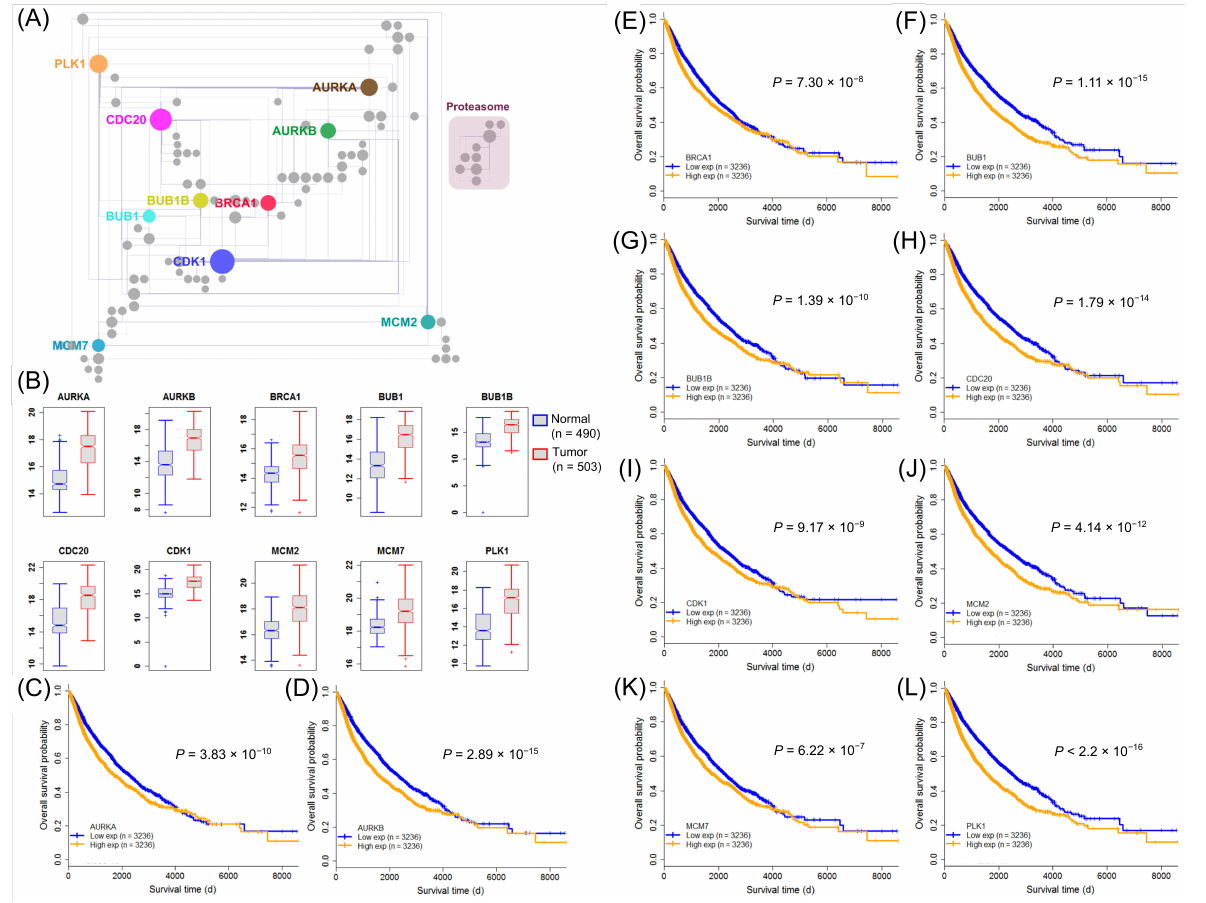
Figure 7. Clinically relevant genes in pan-cancer. ( A ) The human interactome of significantly co-expressed pan-cancer harmful genes (harmful proteins) in the MSigDB category of proliferation. Nodes represent genes and edges protein-protein interactions. Node size is proportional to the degree of the node. Nodes shown in color represent nodes with the 10 highest degrees. ( B ) Expression profile of clinically relevant genes in primary tumor and matched normal samples of pan-cancer. The RSEM normalized expression value is displayed in the log2 (x + 1) scale. ( C – L ) Survival estimates of overall survival in pan-cancer patients (n = 6584). Kaplan-Meier plots of low expression and high expression groups, based on the median expression. The p -values were obtained using a Mantel log-rank